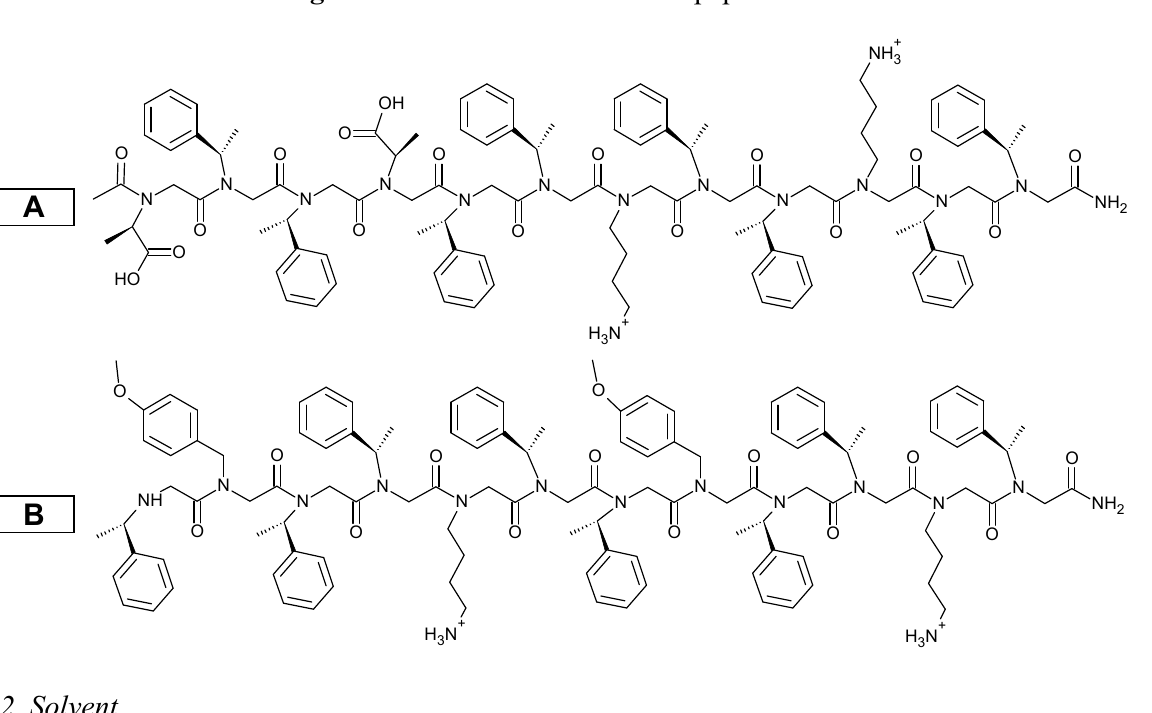
Figure 1. Chemical structures for peptoids A and